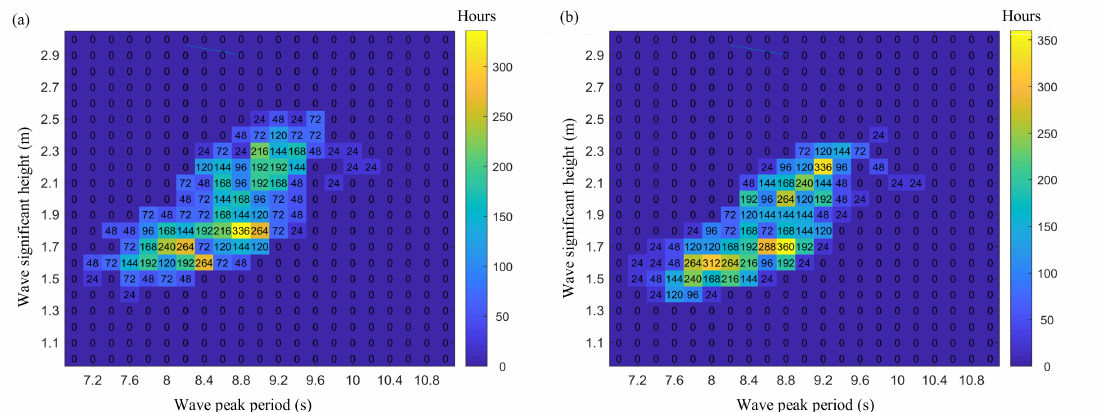
Figure 13. Wave scatter diagrams of the selected locations; ( a ) location 2 off the Yogyakarta coast and ( b ) location 1 off the Penyu Bay coast.